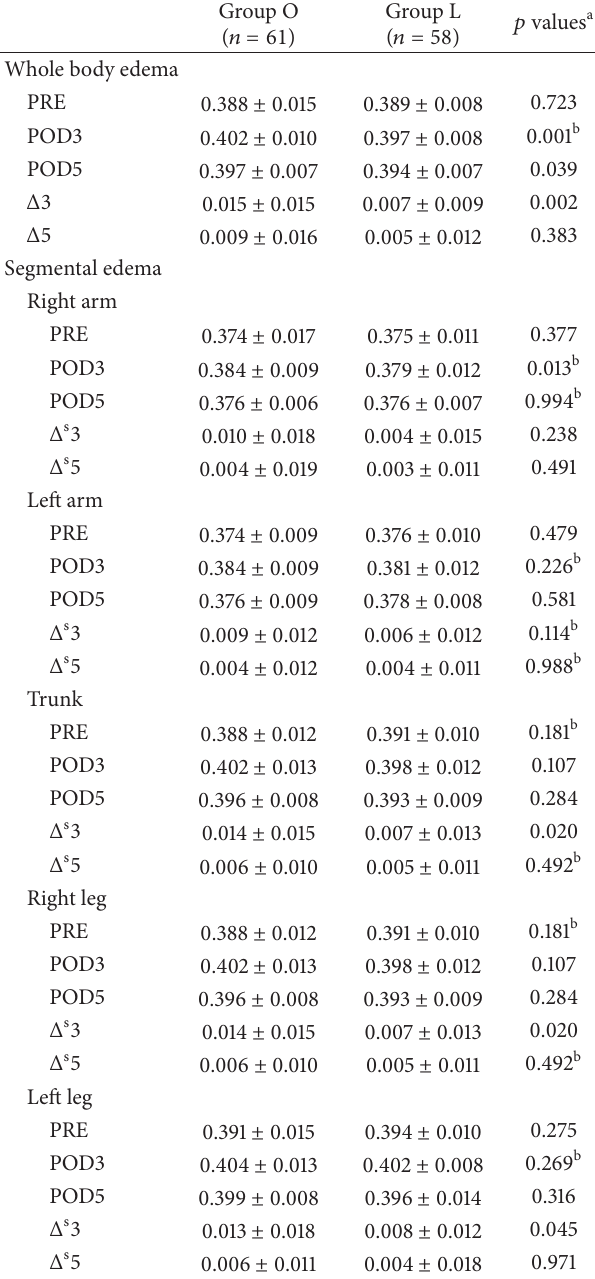
Table 5: The evolution of edema index and segmental edema index between